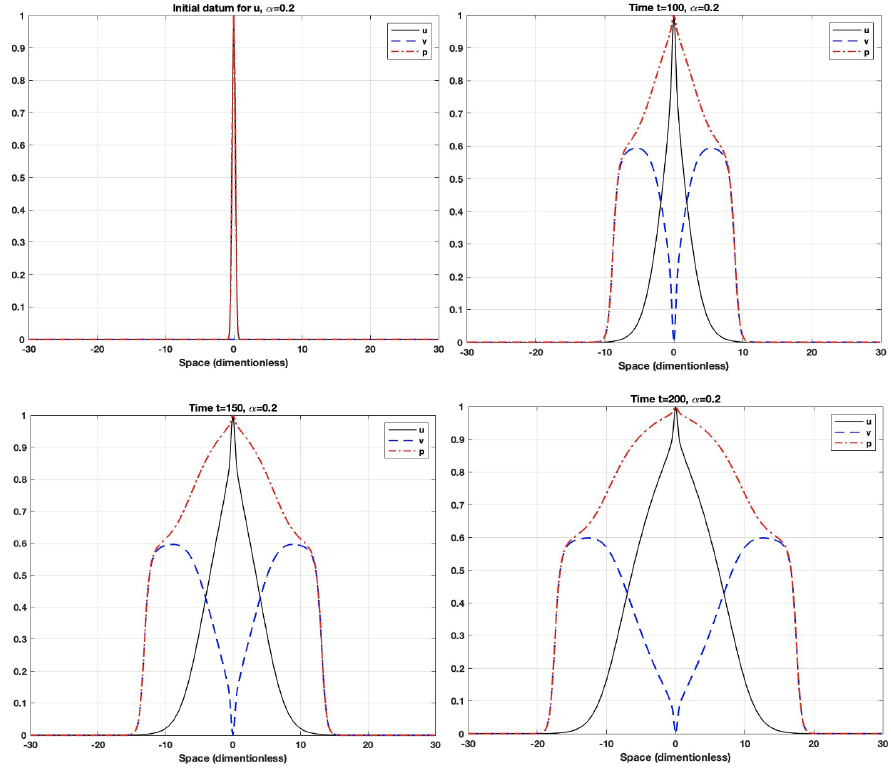
Figure 5. Distribution of CSCs (black), NSCCs (blue) and total tumour density (red). For small mortality rate of NSCCs ( α = 0.2 ) at various total times T ∈ { 0,100,150,200 } and fractional order of time derivative β =